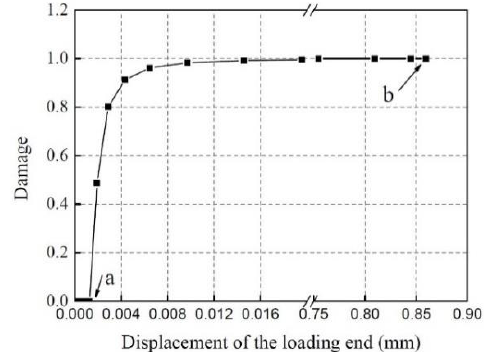
Figure 12. Damage of the first element at the edge of the brazing seam.